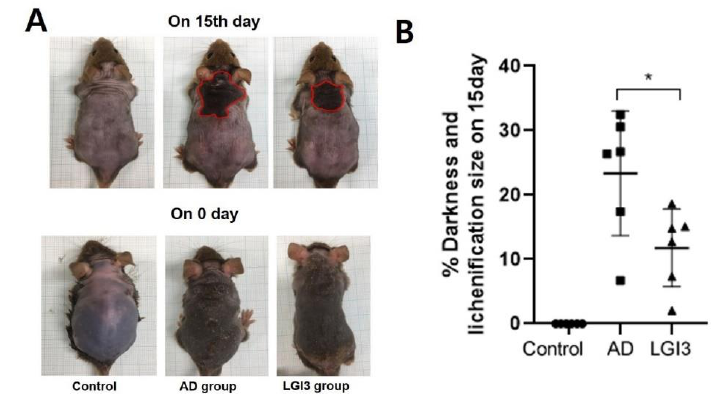
Figure 2. Representative photographs showing a comparison of atopic dermatitis (AD) skin lesions in the control, AD, and leucine-rich glioma inactivated 3 (LGI3) group (n = 7). The AD and LGI3 group are characterized by AD induction on day zero compared to the control group. LGI3 treatment attenuates AD compared to the AD group on day 15.